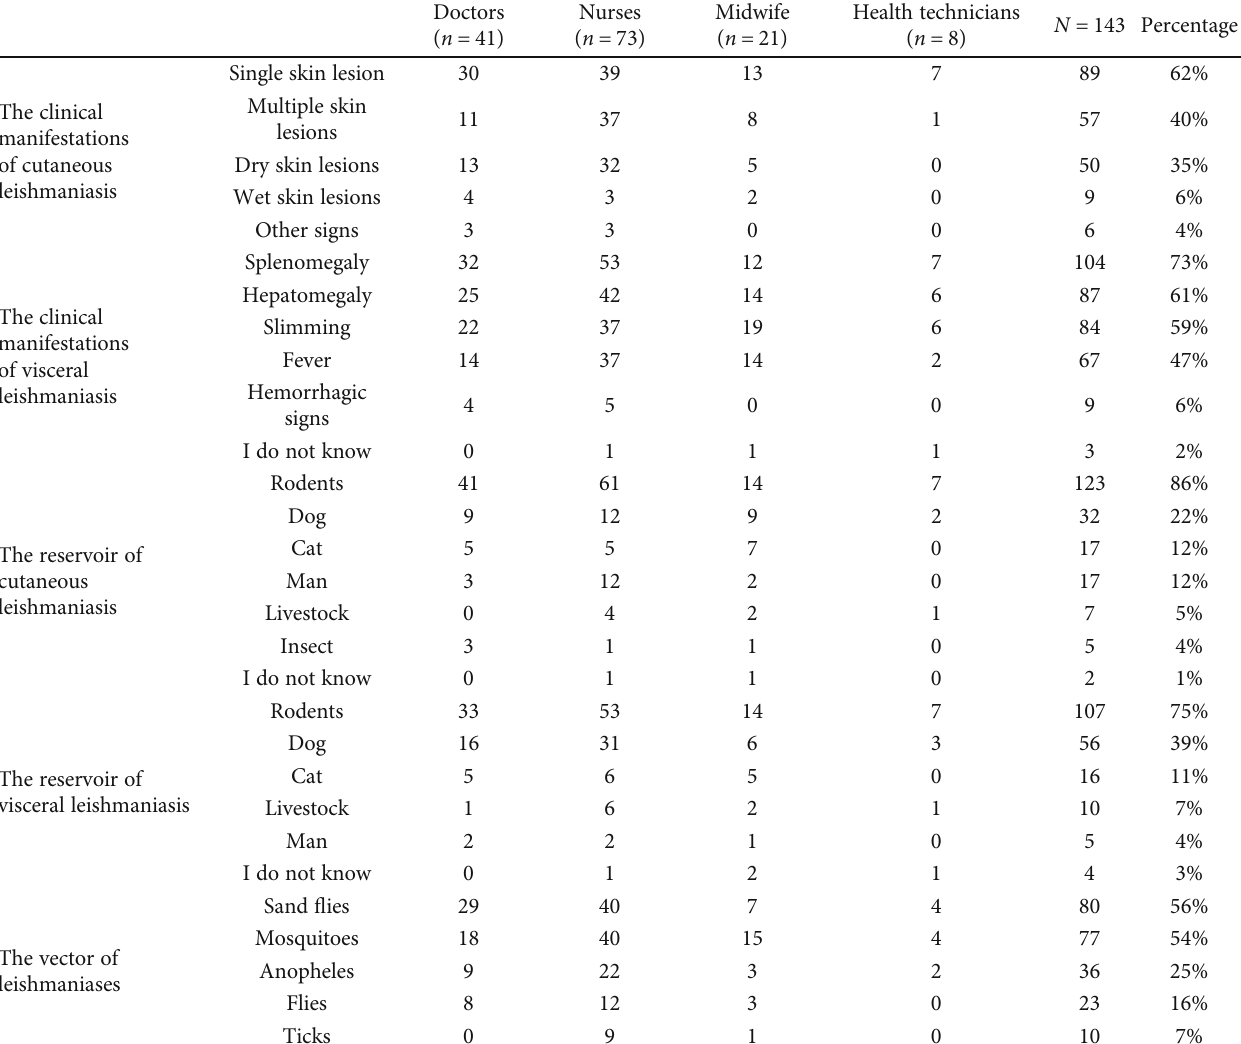
Table 2: Health professionals ’ knowledge of leishmaniases, vector, and